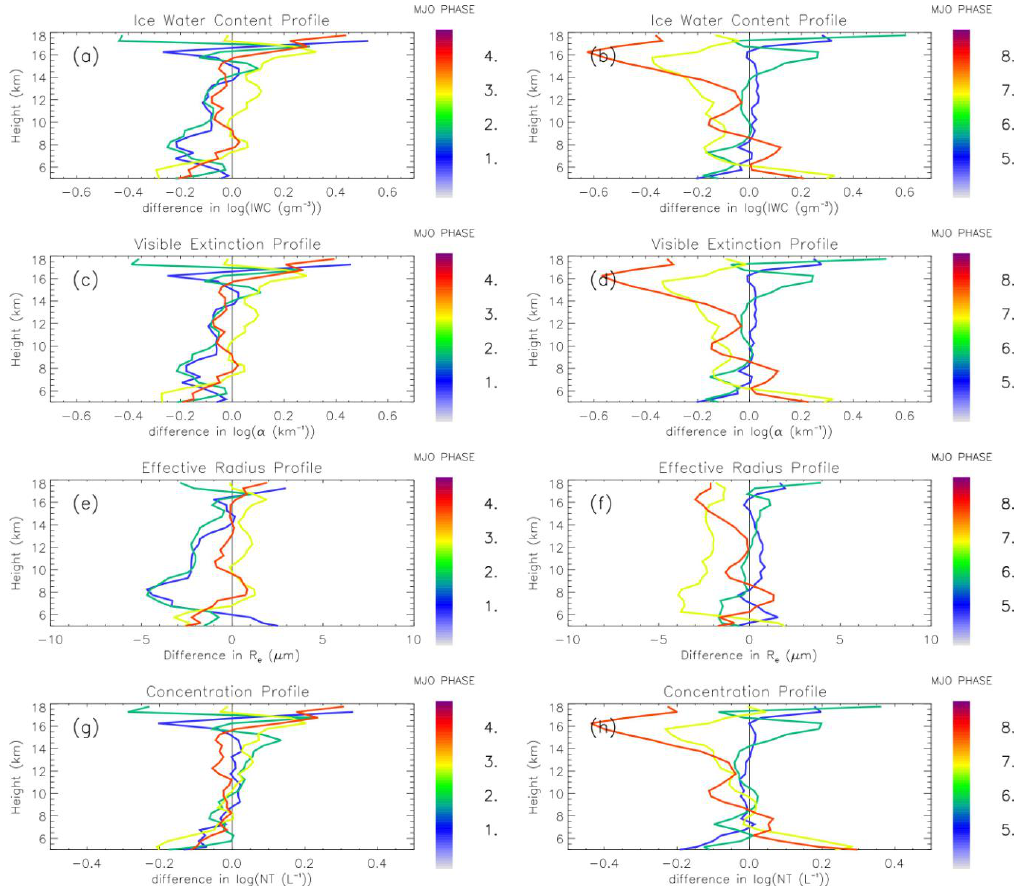
Figure 21: Mean vertical profiles of the difference (phase-total) in microphysical and radiative properties of ice clouds: (a, b) ice water content (in gm − 3 ) , (c, d) visible extinction (in km − 1 ) , (e, f) effective radius (in µm) and (g, h) total concentration (in l − 1 ) over Darwin for each MJO phase (left panels for MJO phases 1 to 4, right panels for MJO phases 5 to 8).